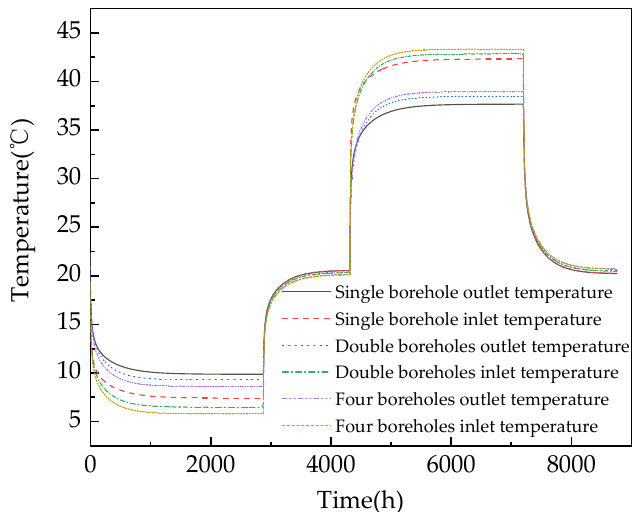
Figure 6. Changes in the inlet and outlet temperatures throughout the year.